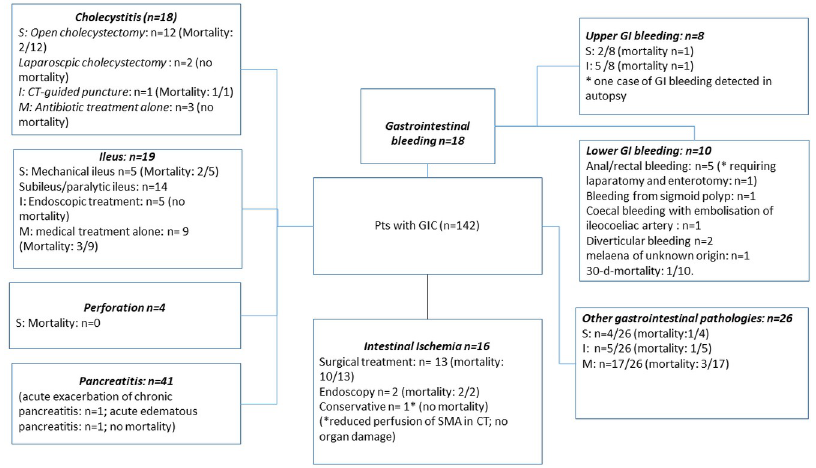
Fig 2. Treatment and outcome details of all patients with gastrointestinal complications. S surgical intervention, I interventional treatment, M medical treatment, CT computed tomography, GIC gastrointestinal complication, SMA superior mesenteric artery, GI